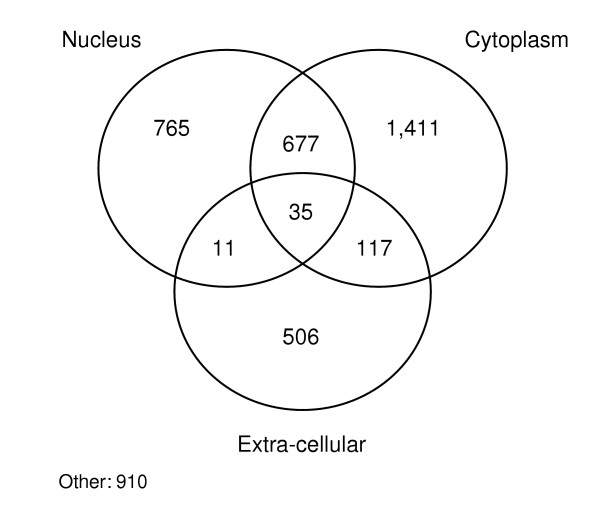
Distribution of RefSeq/HomoloGene proteins across HPRD cellular localization bins. Protein interactors from BIND were mapped to HomoloGene to delineate homologs across the four organisms, and to associate each protein to a sub-cellular compartment.